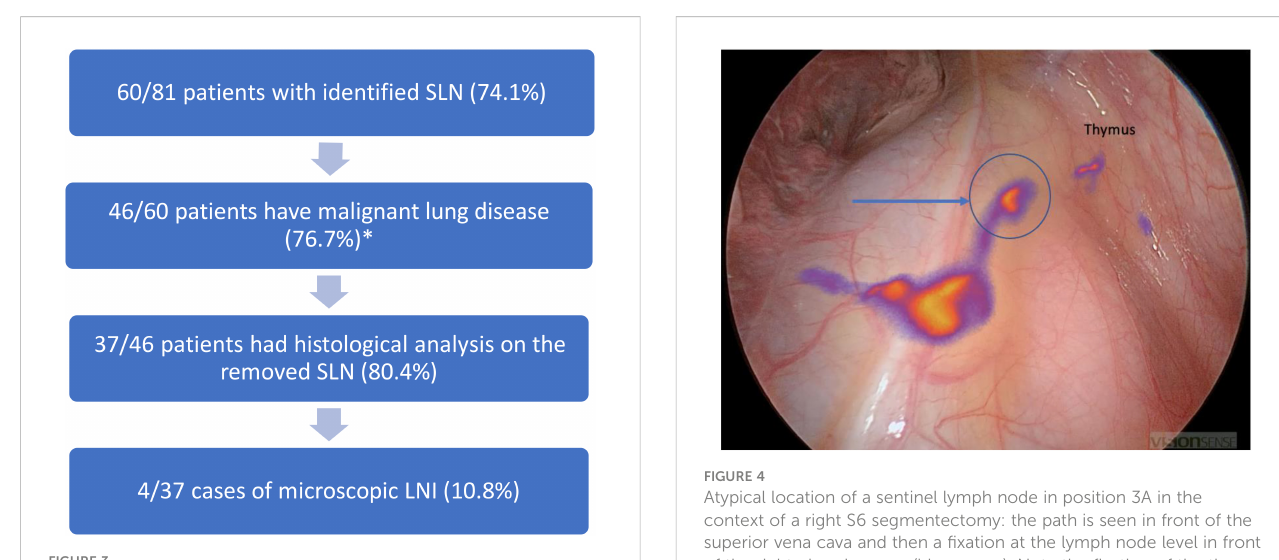
FIGURE 3 Flow chart of the 81 patients included in the study. *: 3 patients with metastases were removed from this